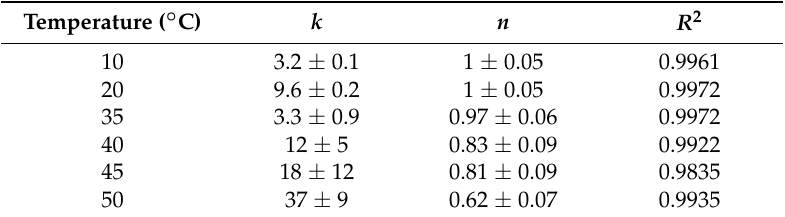
Table 1. Values of the fittings of the experimental front thicknesses of Figure 3 to Equation (1), and the corresponding coefficients of determination.